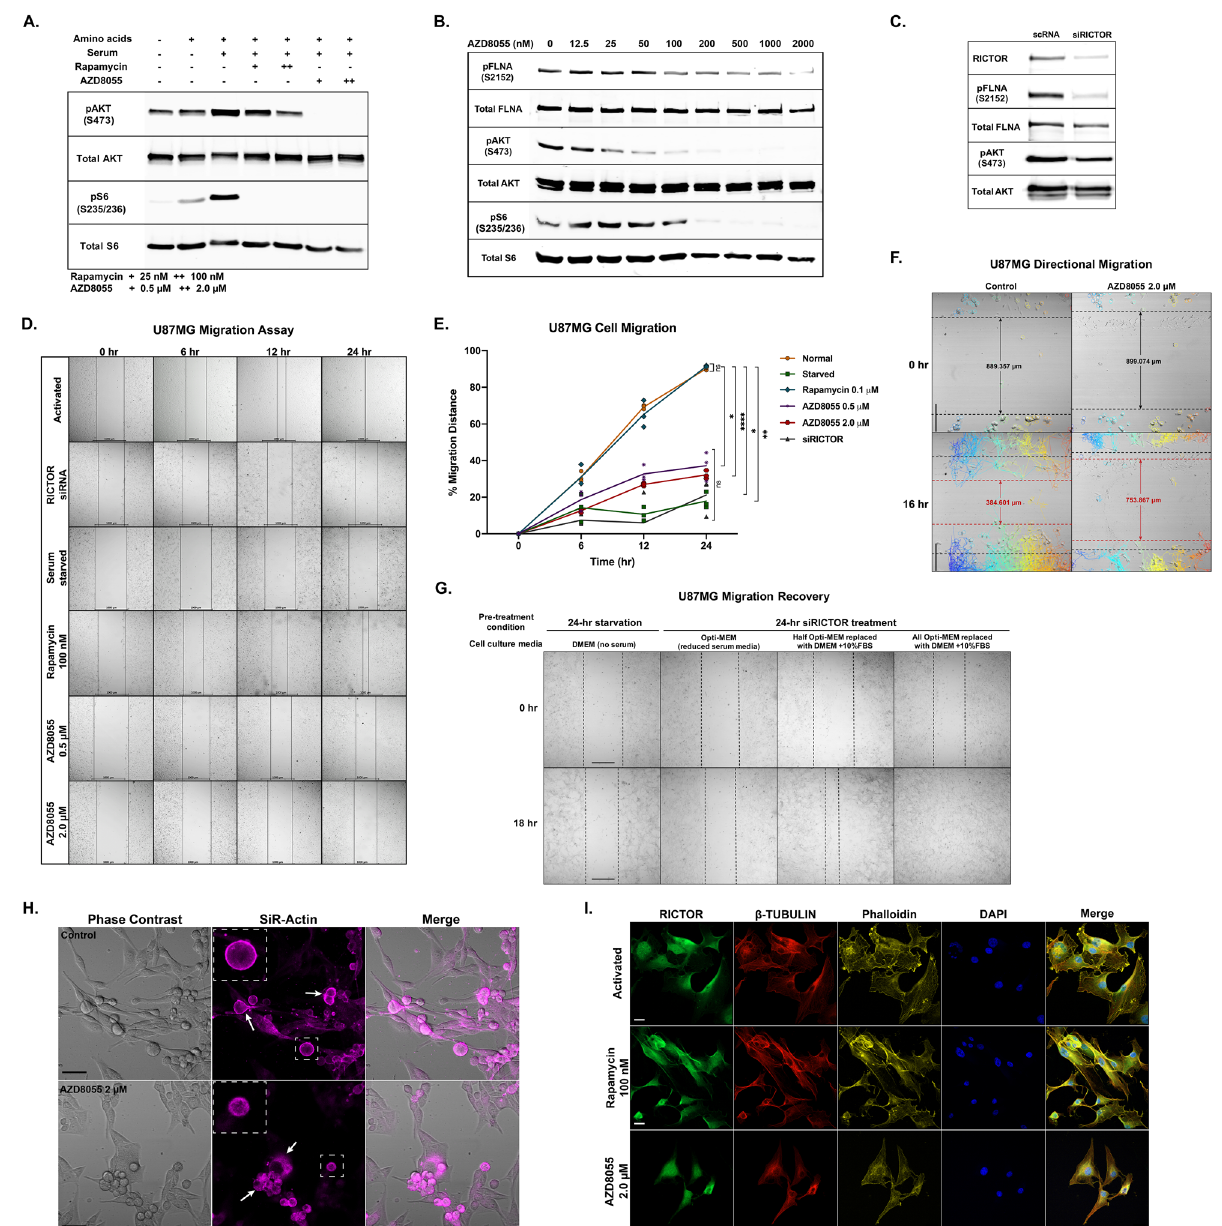
Figure 1. mTORC2 signaling pathway and cell migrational control in U87MG cells. (A) Western blot showing activation of mTORC1 (pS6) and mTORC2 (pAKT) by amino acids and serum and inhibition by rapamycin and AZD8055. (B) Western blot showing dose-dependent inhibition of mTORC1 (pS6) and mTORC2 (pFLNA and pAKT) by AZD8055. (C) Western blot analysis of RICTOR, pFLNA, and pAKT showing mTORC2 kinase activities after RICTOR knockdown. (D) Wound-healing migration assays of U87MG cells under activation and inhibition (siRICTOR, serum starvation, 100 nM rapamycin, 0.5 µM and 2.0 µM AZD8055) conditions at 0, 6, 12, and 24 h. Scale bar, 100 µm. (E) Migration distance percentage quantification of U87MG cells under different culturing conditions shown in (D); n = 3. Statistical significance was calculated at the endpoint (24 h) using two-way ANOVA with Tukey’s multiple-comparisons test comparing each treated group with the normal group: * p < 0.05, ** p < 0.01, *** p < 0.001, **** p < 0.0001, ns = not significant. (F) Directional migration (16 h) of normal and 2.0 µM AZD8055-treated U87MG cells. Colored-tracking lines represent the migrating direction of each cell in a circle. Scale bar, 200 µm. See also Video S1. (G) Cell migration recovery by serum supplementation (18 h) of siRICTOR-treated cells. Scale bar, 100 µm. See also Video S2. (H) Snapshot from live-cell imaging of U87MG cells containing actin labeled with SiR-Actin under normal and AZD8055-treated conditions. See also Video S3. Scale bar, 20 µm. (I) Immunofluorescence staining of F-actin and the microtubules of activated, rapamycin-treated (100 nM, 24 h), and AZD8055-treated (2.0 µM, 24 h) U87MG cells. Scale bar, 20